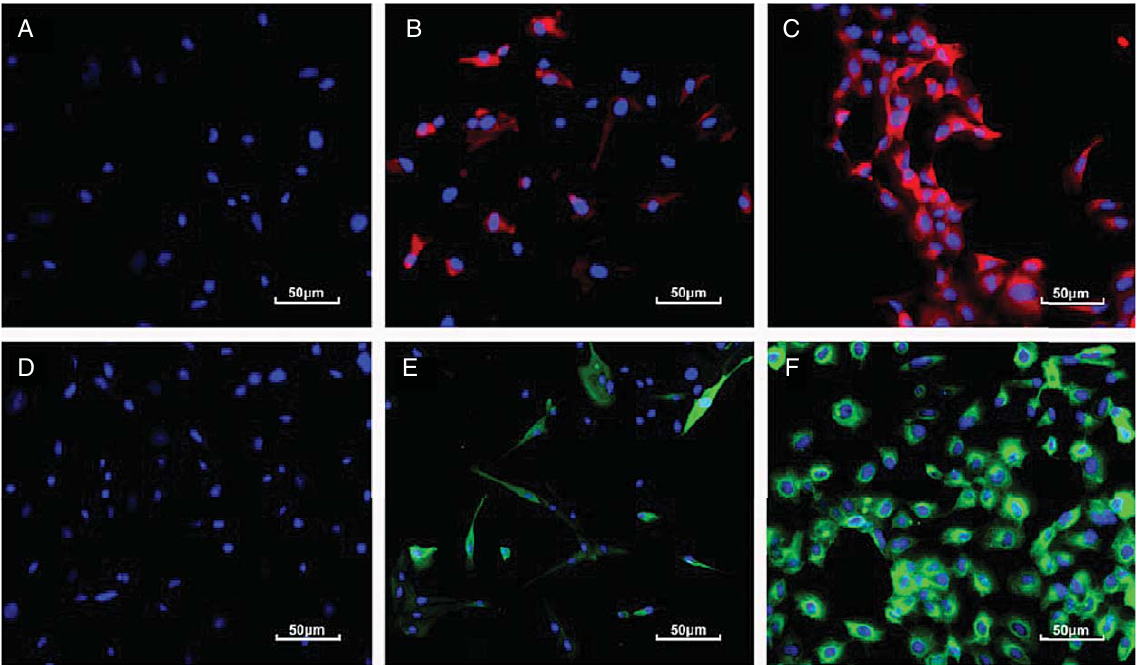
Fig.3. hUCMSCswereassessedbyimmunofluorescencestainingafterdifferentiation.hUCMSCsculturedwithUC-CMsupplemented20ng/ml exogenous EGF were assessed by immunofluorescence staining at day 0 (A, D), days 14 (B, E). UCs were used as positive control (C, F). Cells were immunostained for cytokeratins (red) (A, B, C) and uroplakin II (green) (D, E,